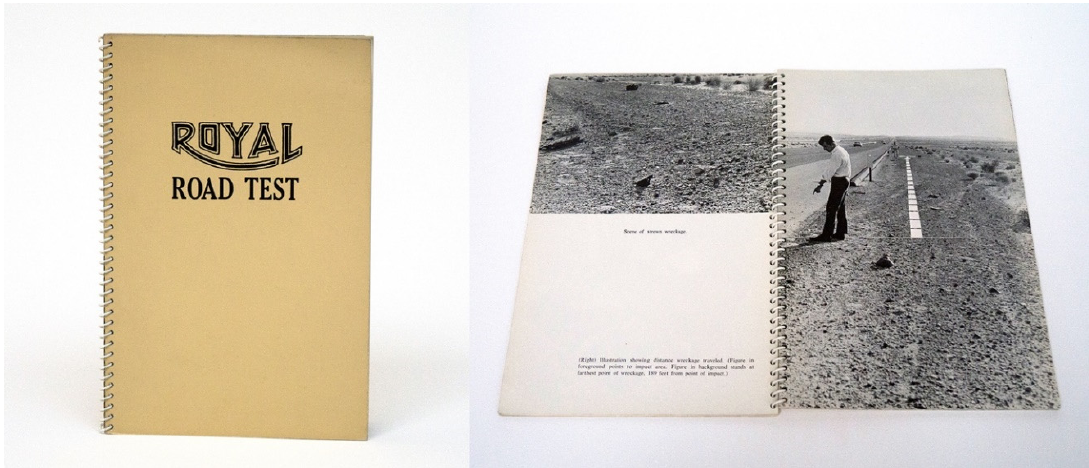
Figure 5. Mason Williams, Edward Ruscha, Patrick Blackwell, Royal Road Test , 1967.